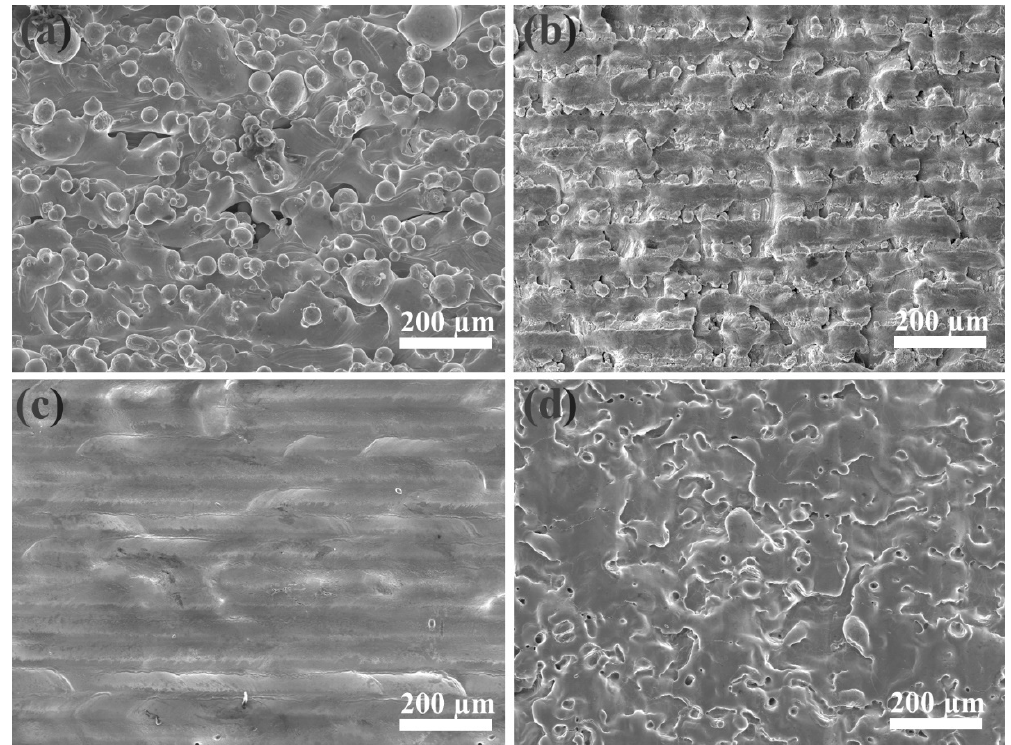
Figure 2. Scanning electron microscope ( SEM) images of the ( a ) as-received sample, the ( b ) LP-1 sample, the ( c ) LP-2 sample, and the ( d ) LP-3 sample.